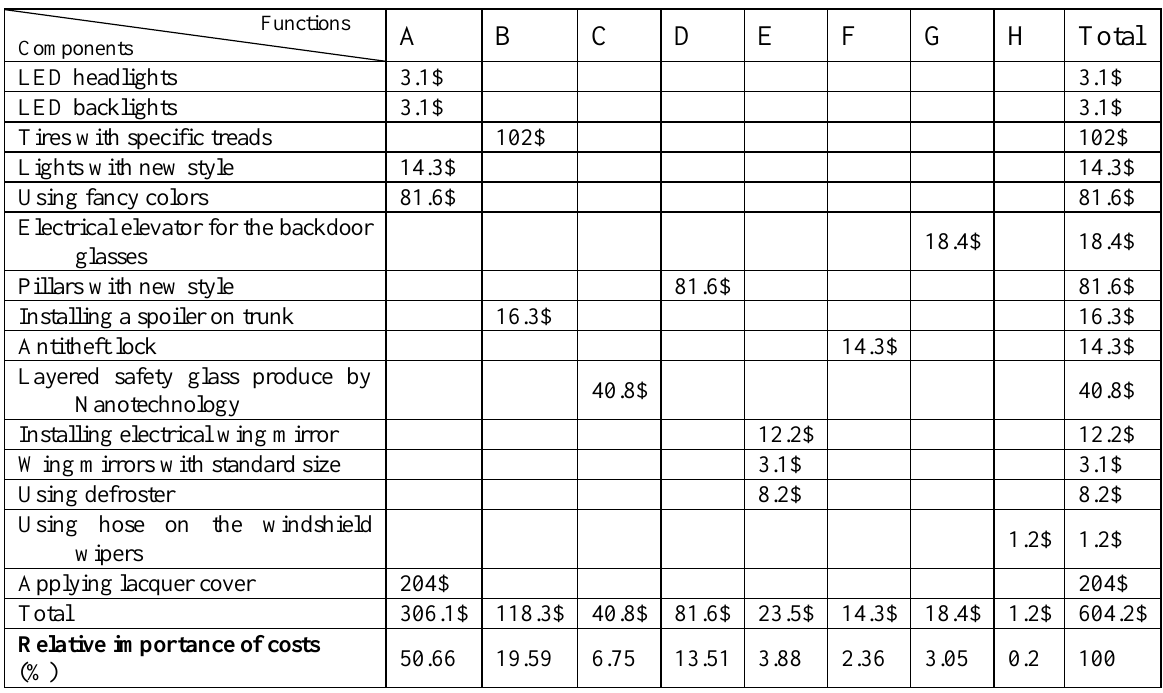
Figure 6. Resource consumption